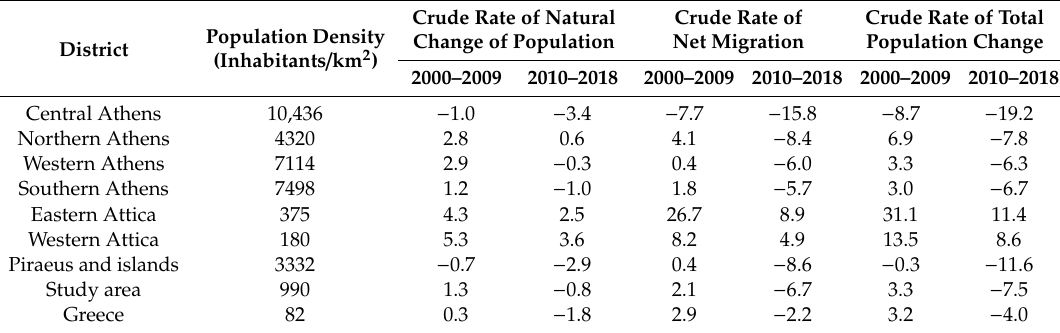
Table 3. Population growth rates in the study area by time window (2000–2009 or 2010–2018) and regional unit (Piraeus and surrounding islands were considered together).